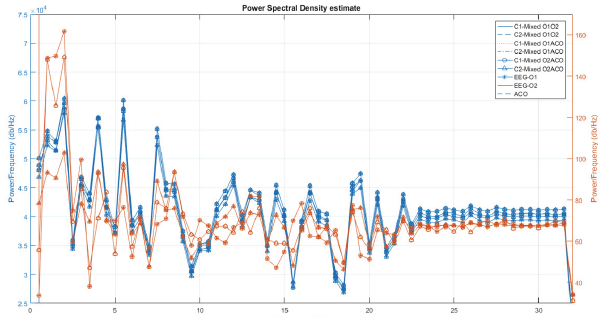
Figure 30: Concentrate representation of PSD. Original and components signals. Green line: stimulus frequency; orange lines: harmonics of stimulus